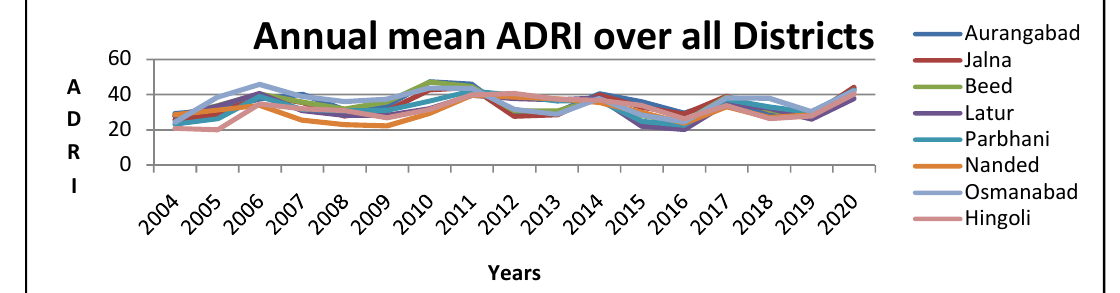
Figure 6: ADRI movement over Districts over Marathwada from 2004 to 2020